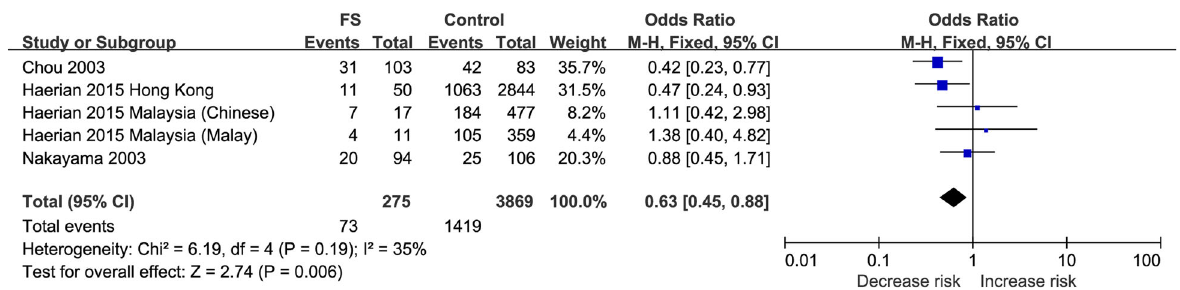
Fig. 3 Forest plot of subgroup analysis in Asian populations. The GABRG2 rs211037 polymorphism was significantly related to decreased risk of FS in Asian